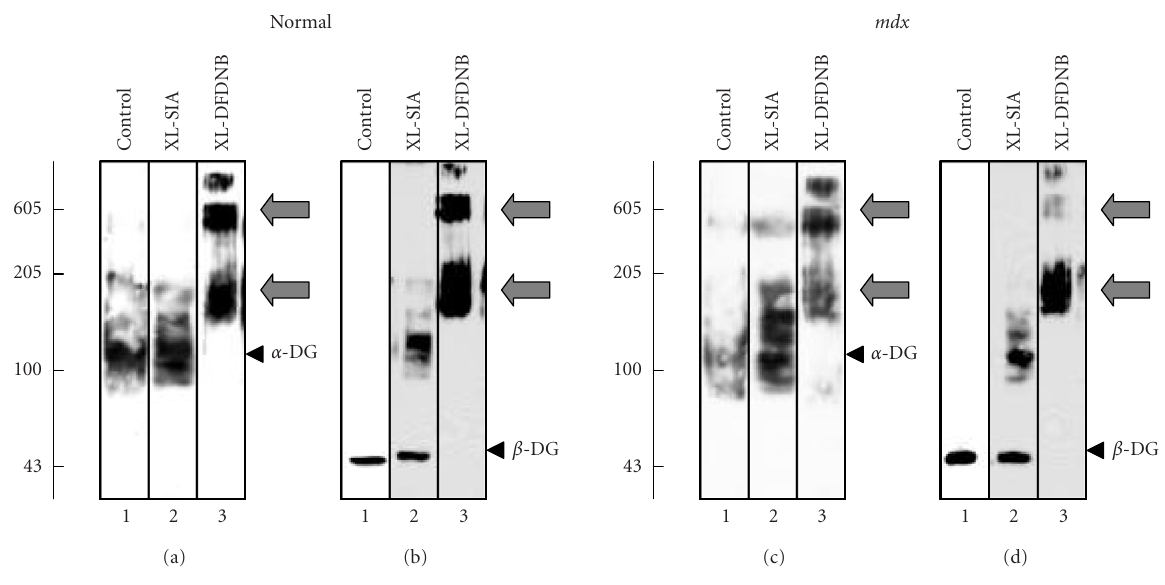
Figure 3. Chemical cross-linking analysis of cardiac dystroglycan complex. Shown are immunoblots of normal ((a), (b)) and mdx ((c), (d)) membranes from 15-week-old mice labelled with antibodies to α -dystroglycan ( α -DG) ((a), (c)) and β -dystroglycan ( β -DG) ((b), (d)). Lanes from 1 to 3 represent cardiac membranes incubated with no cross-linker probe (control), with 50 µ g cross-linker N- succinimidyl-iodoacetate (XL-SIA) and 50 µ g cross-linker 1 , 5-difluoro-2 , 4-dinitrobenzene (XL-DFDNB) per mg membrane protein, respectively. Monomeric immuno-decorated protein bands are indicated by arrow heads and cross-linker-stabilised oligomeric forms are marked by arrows. For the direct comparison of cross-linker-induced changes in the electrophoretic mobility of dystroglycans, equal amounts of dystroglycan molecules were analysed. Hence, a higher concentration of mdx membranes was used to perform chemical cross-linking as compared to normal membranes. Molecular mass standards ( × 10 − 3 ) are indicated on the